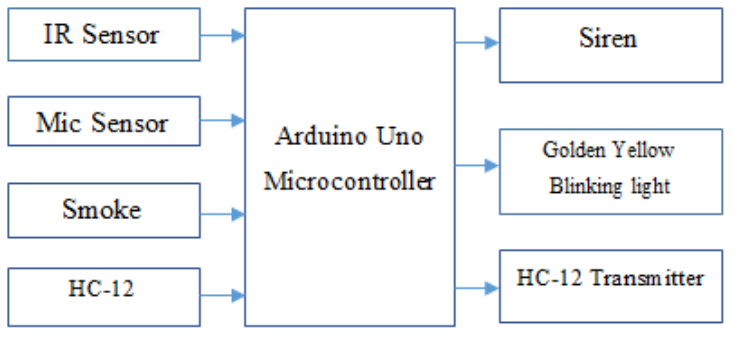
Figure 3. Block diagram of a node in the proposed AALS system.